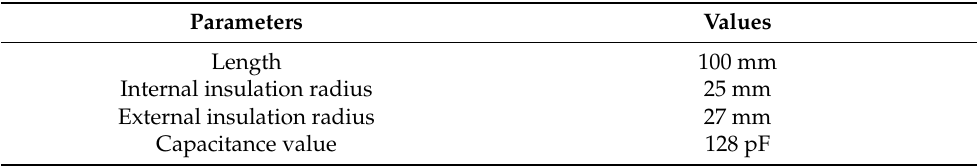
Table 5. Capacitor specific